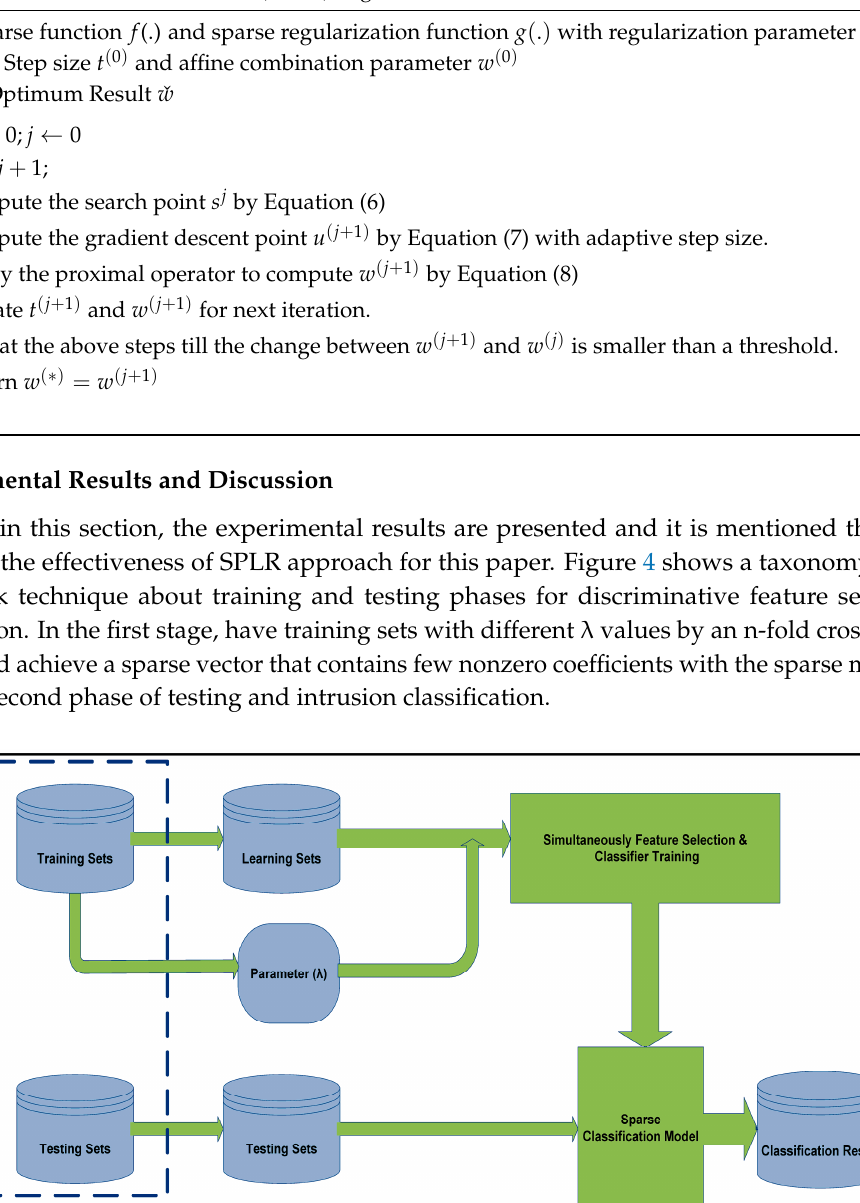
Algorithm 1. Pseudo code for SPLR (Lasso) Algorithm.